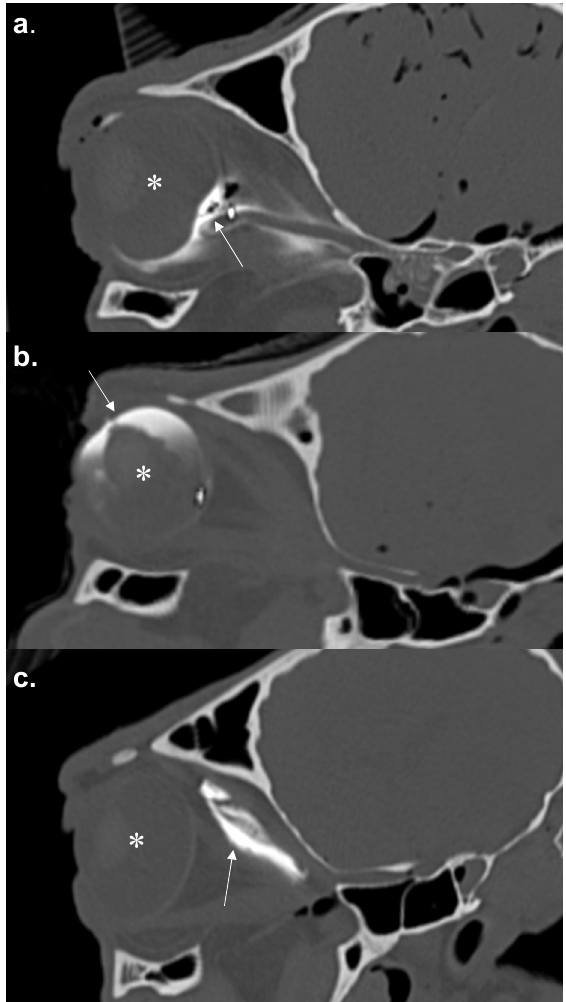
Figure 3. Oblique parasagittal (aligned along the optic cone) reconstructions of the computed tomographic (CT) scans of three optic cones with central ( a ), anterior ( b ) and peripheral ( c ) distribution of contrast medium. The arrows indicate the distribution of contrast medium (CM) and the asterisk the eyeball. Table 2. Variables measured in the different groups (1–3): The number of RNBs that showed staining of methylene blue dye within the bulbus at dissection (positive) versus the number of injections that did not show staining at dissection (negative); the position of the needle within the periorbita measured by CT; contrast distribution of the CM in mm from the optical foramen measured by